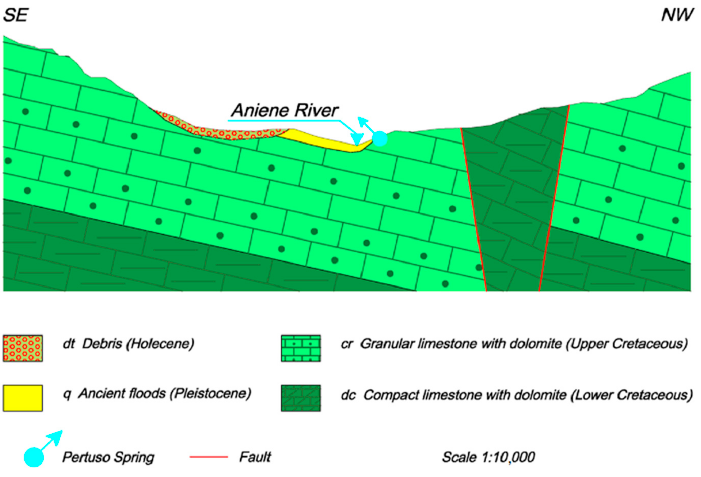
Figure 2. Geological cross ‐ section of the Pertuso Spring.